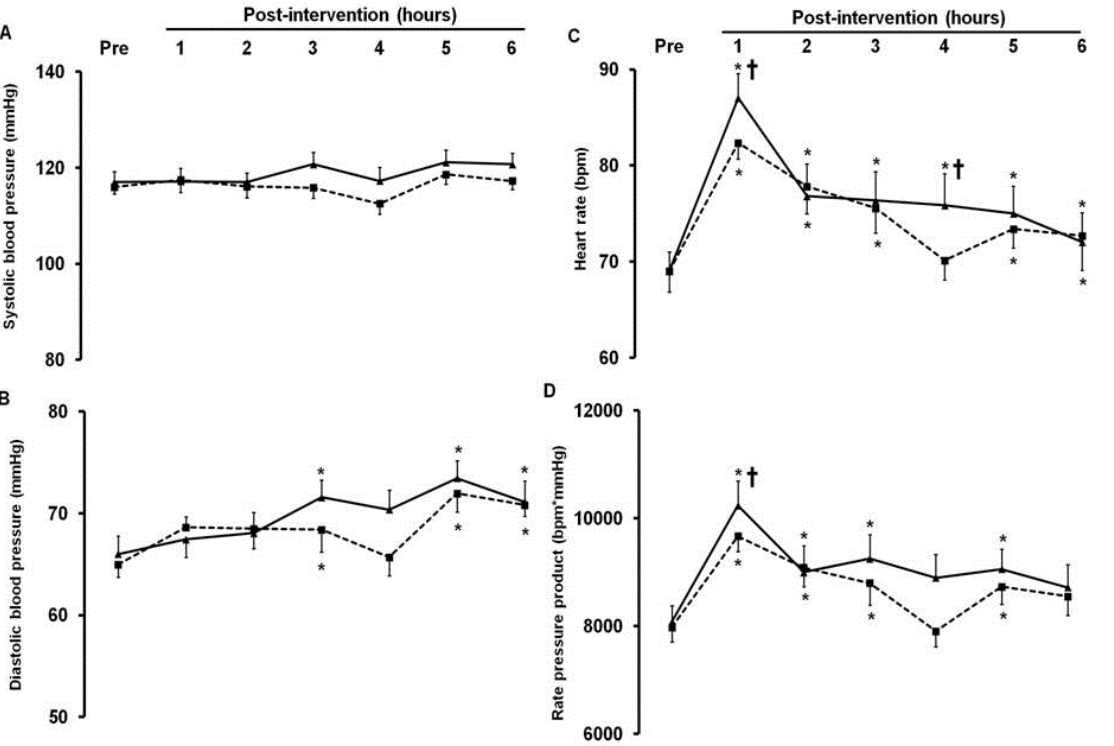
Figure 1. Systolic blood pressure (panel A), diastolic blood pressure (panel B), heart rate (panel C) and rate- pressure product (panel D) pre- and post- intervention for resistence exercise sessions performed with 30 seconds (filled line) and 90 seconds (dashed line) rest intervals * Significantly different from pre-values (p<0.05);  Significantly different from l90